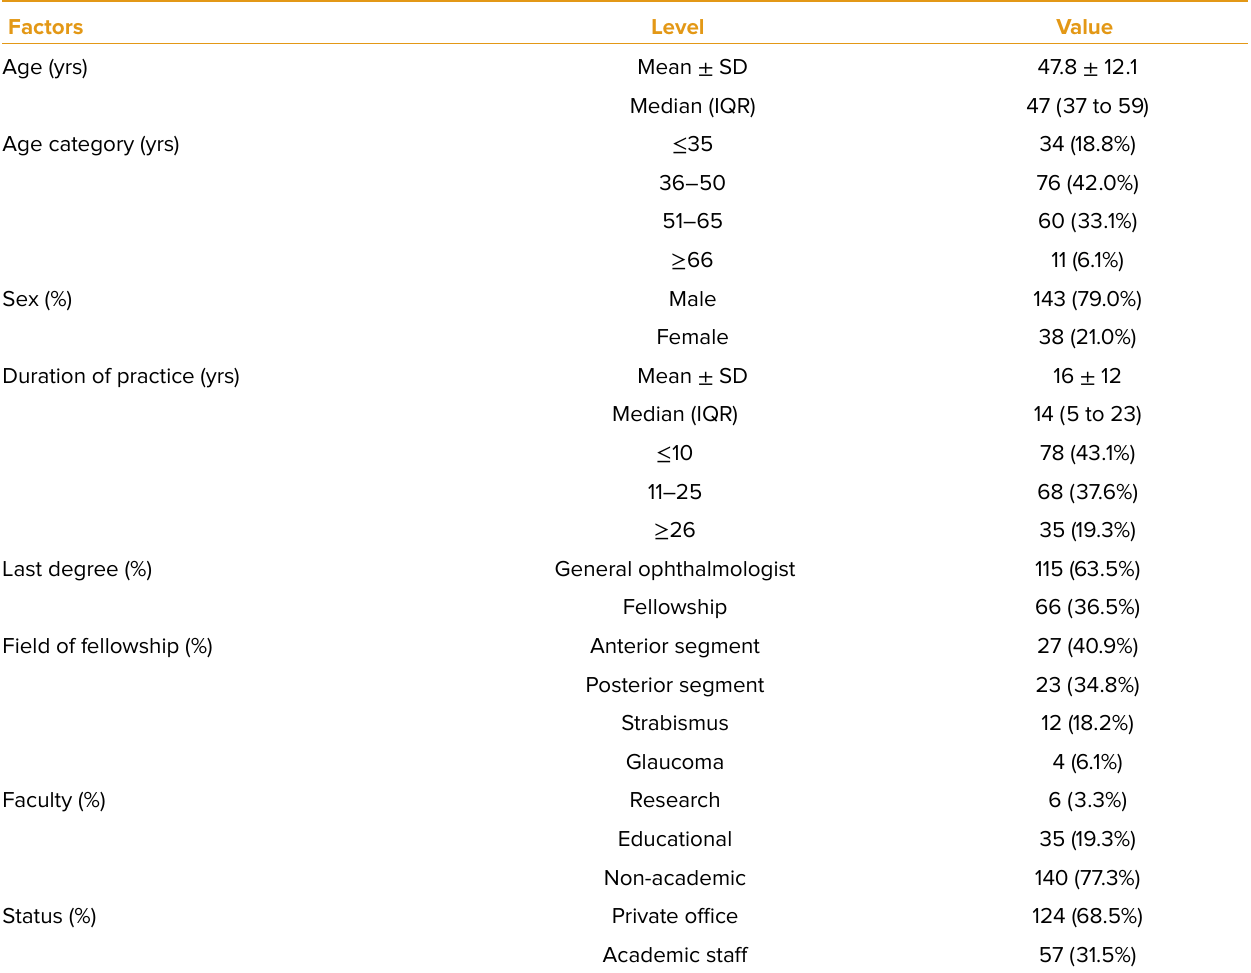
Table 1. Demographic characteristics of the study subjects.